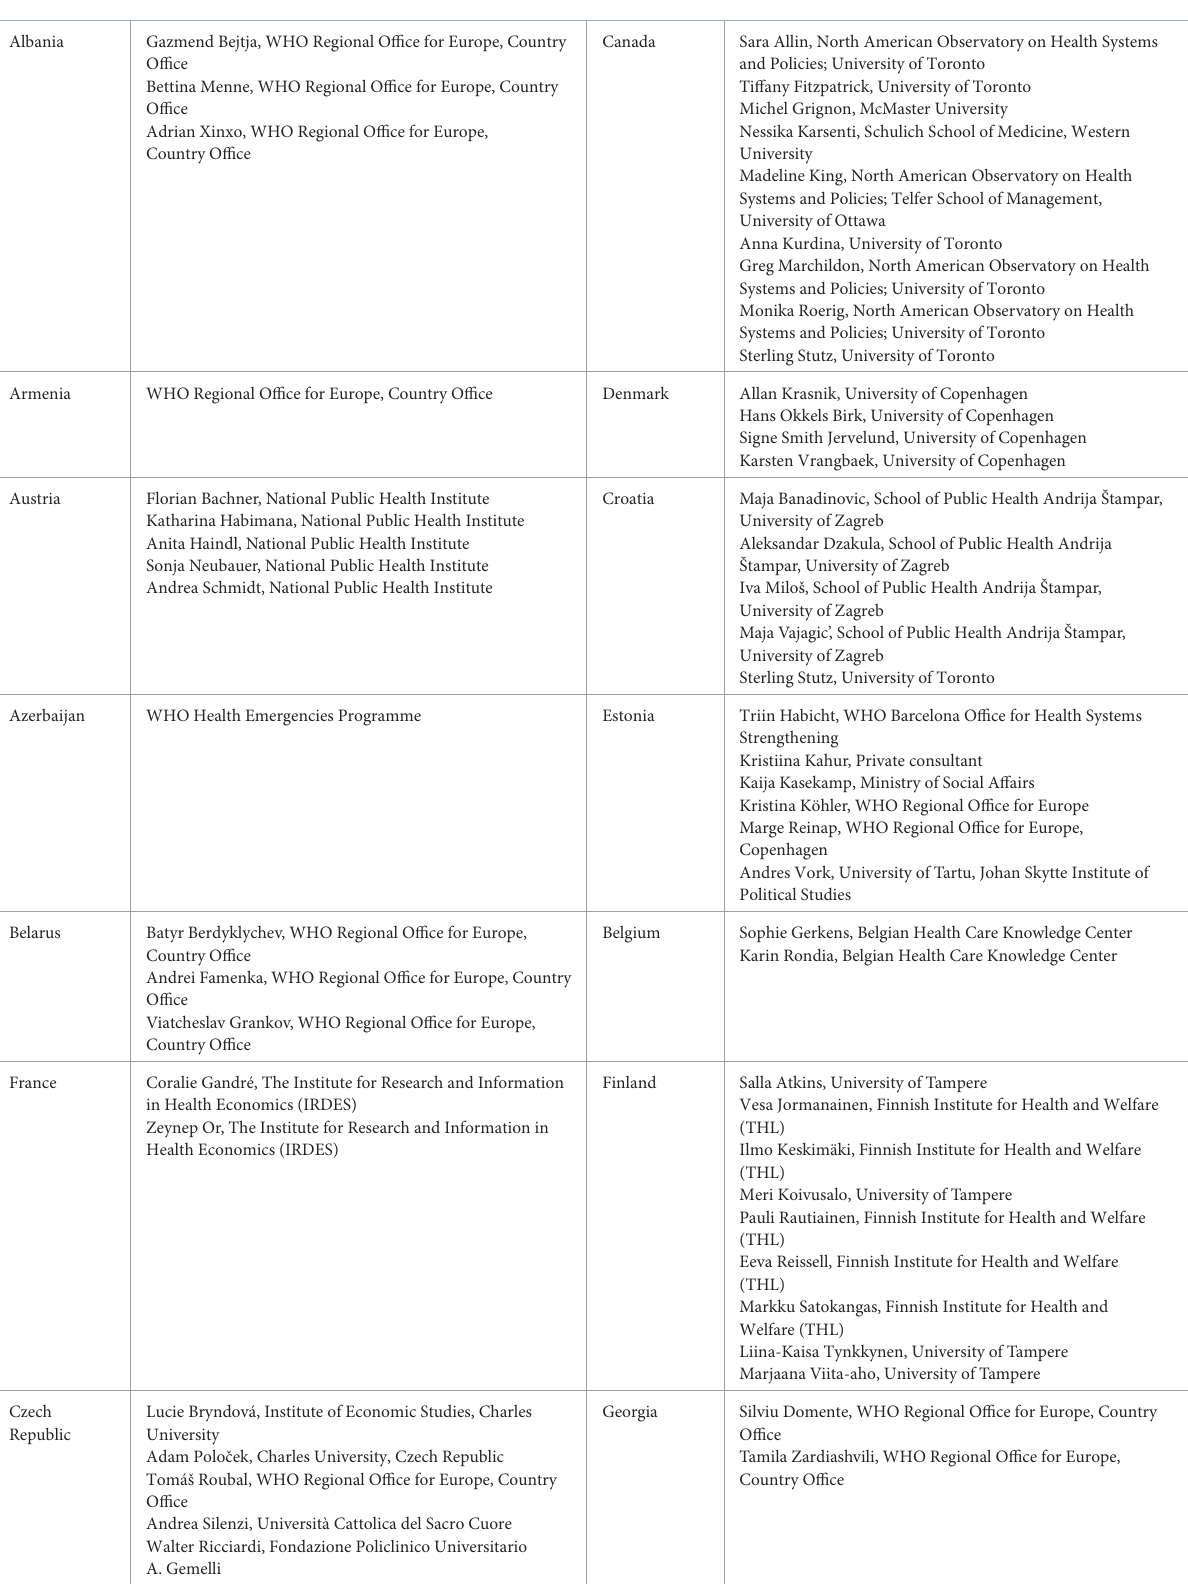
TABLE 1 World Health Organizations location by the